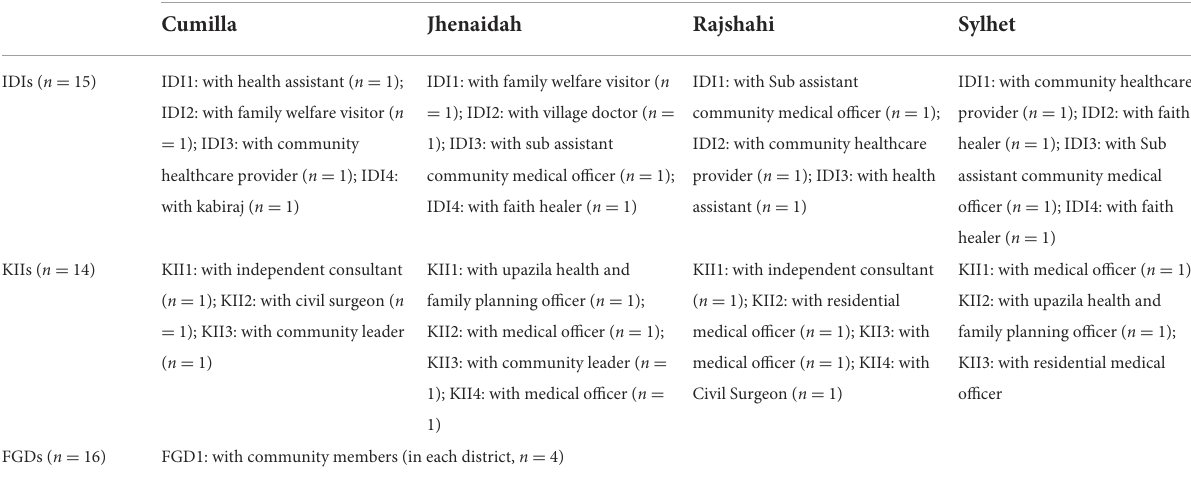
TABLE 1 Data collection methods and study